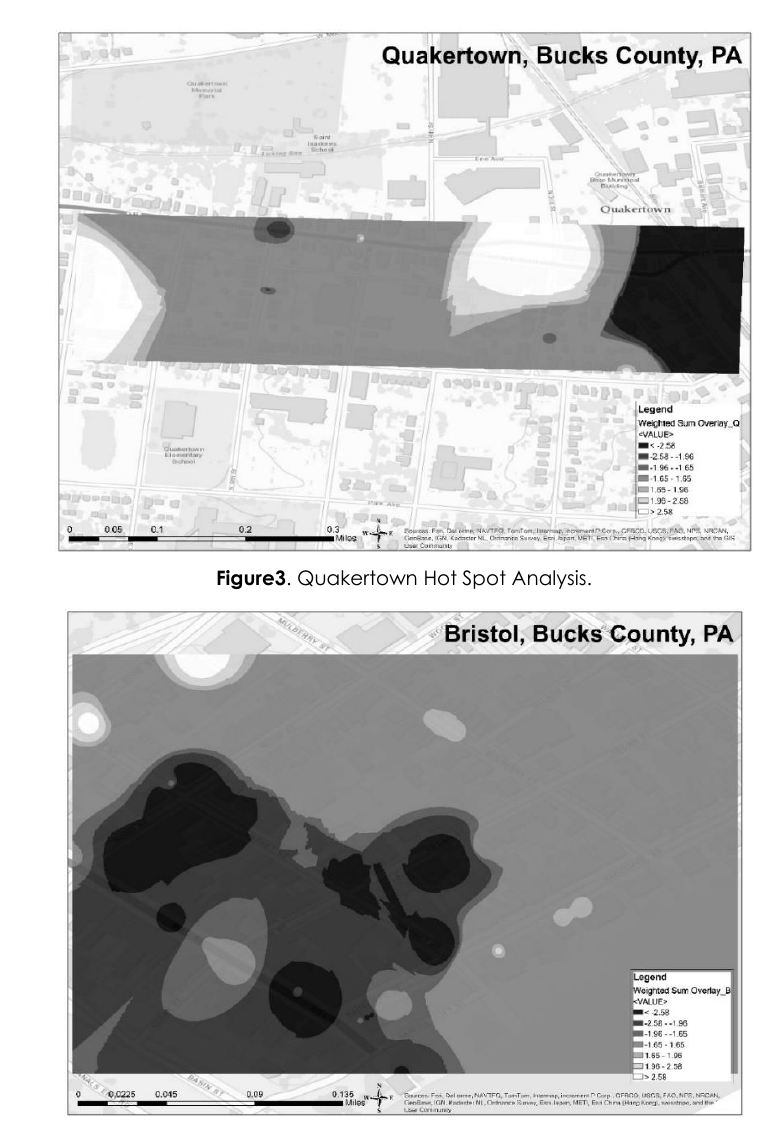
Figure 4. Bristol Hot Spot